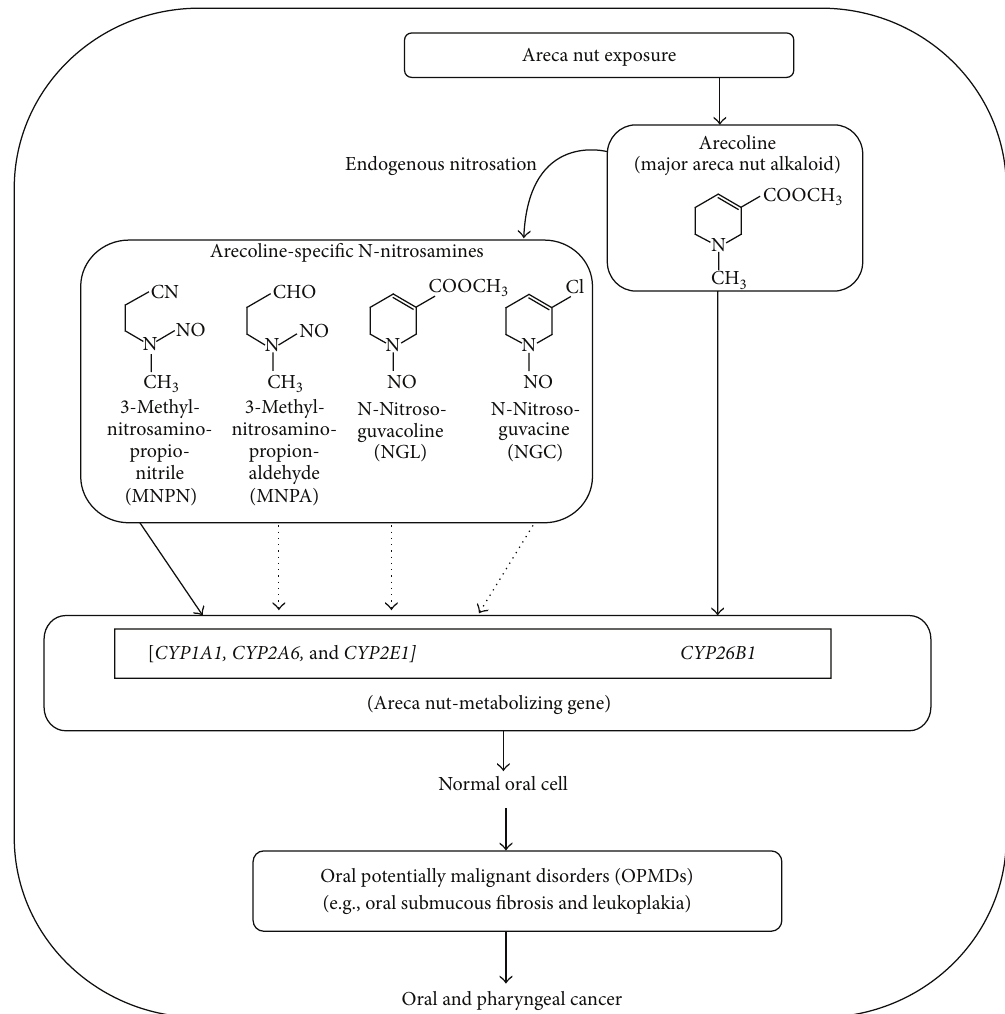
Figure 1: Simplified flow chart for postulated main effects of areca nut induced oral carcinogenesis via cytochrome P450 ( CYP ) gene.